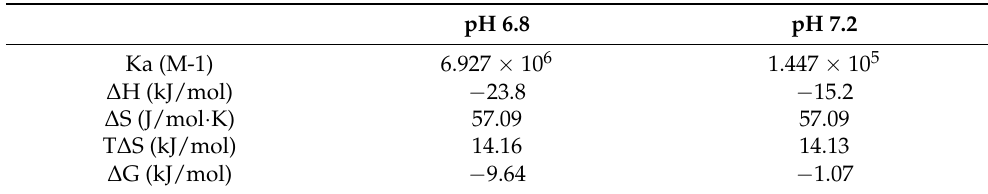
Table 2. Thermodynamic parameters of the interactions between CS and SS assembled carrier materials at pH 6.8 and 7.2.